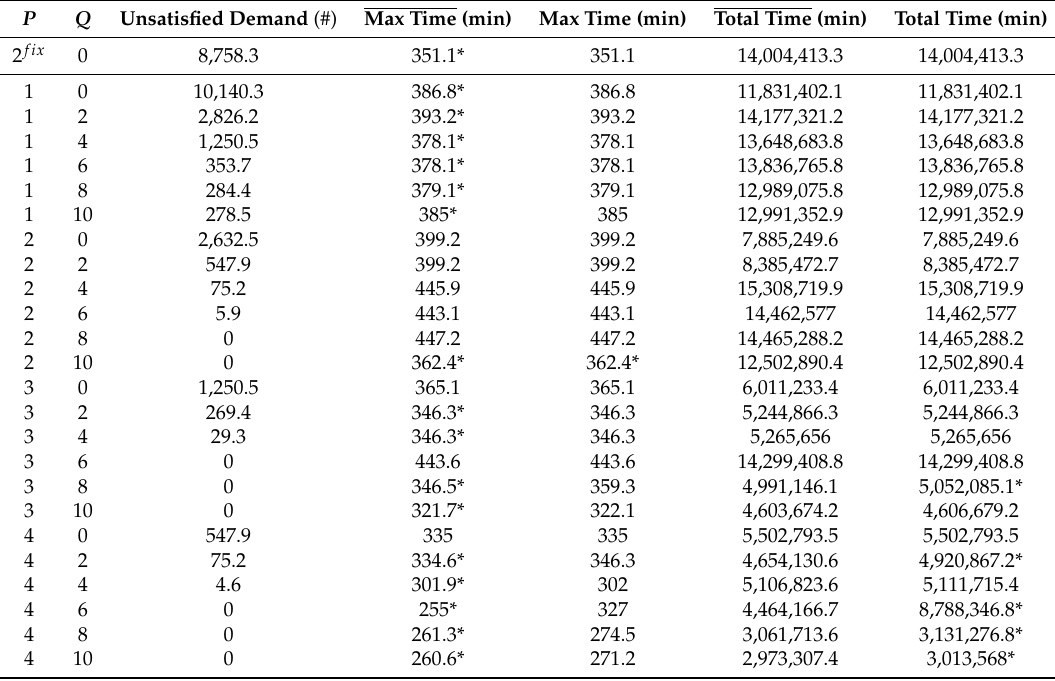
Table 3. Solution values for the experiments on the stochastic